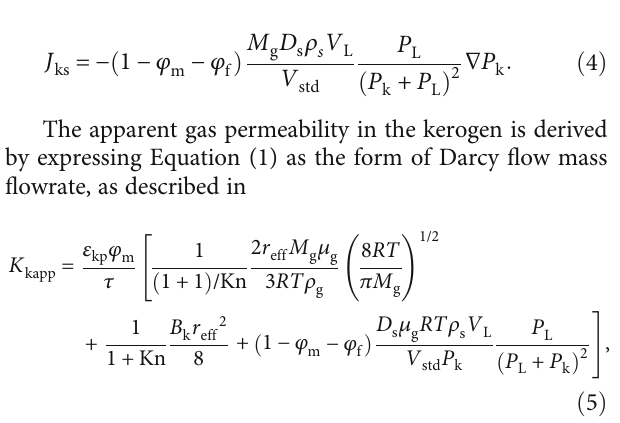
Figure 2: Schematic diagram of multiple physics in kerogen